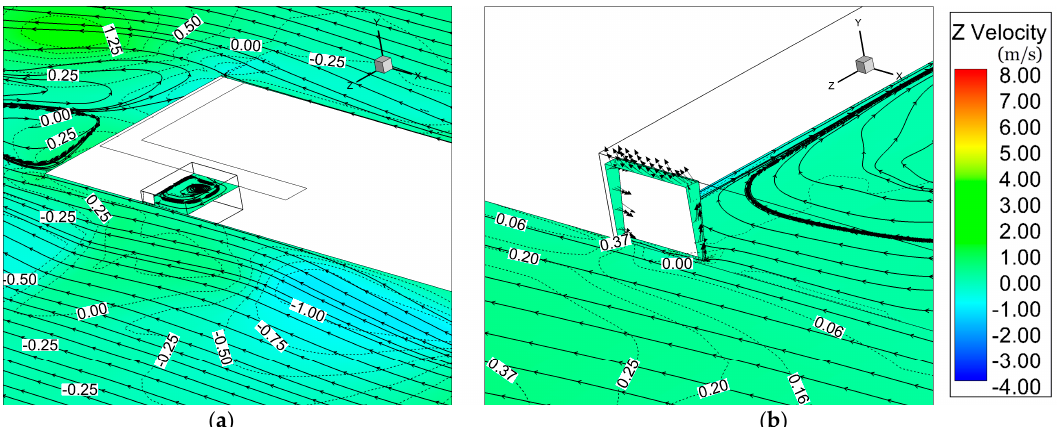
Figure 9. Flow patterns and contour of velocity (z-component), for 6 m / s wind speed and wind direction of 45 ◦ ( a ) around the building and ( b ) in front of the tilted window.